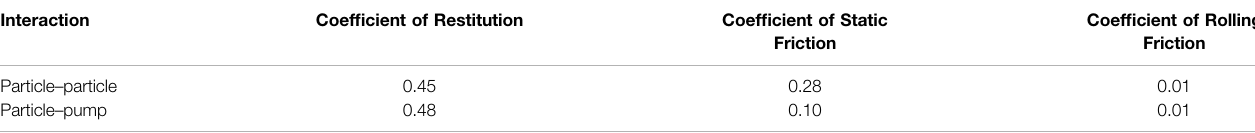
TABLE 1 | Contact interaction settings in the EDEM.